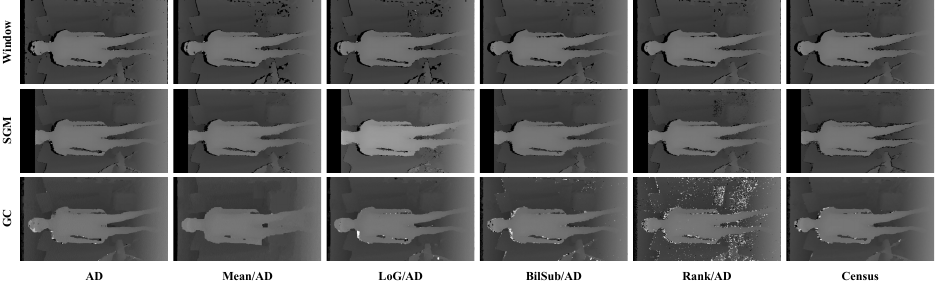
Figure 28. Estimated real disparity images of the combinations of cost and image filter using each stereo matching method. All attributes of active IR images were set to default